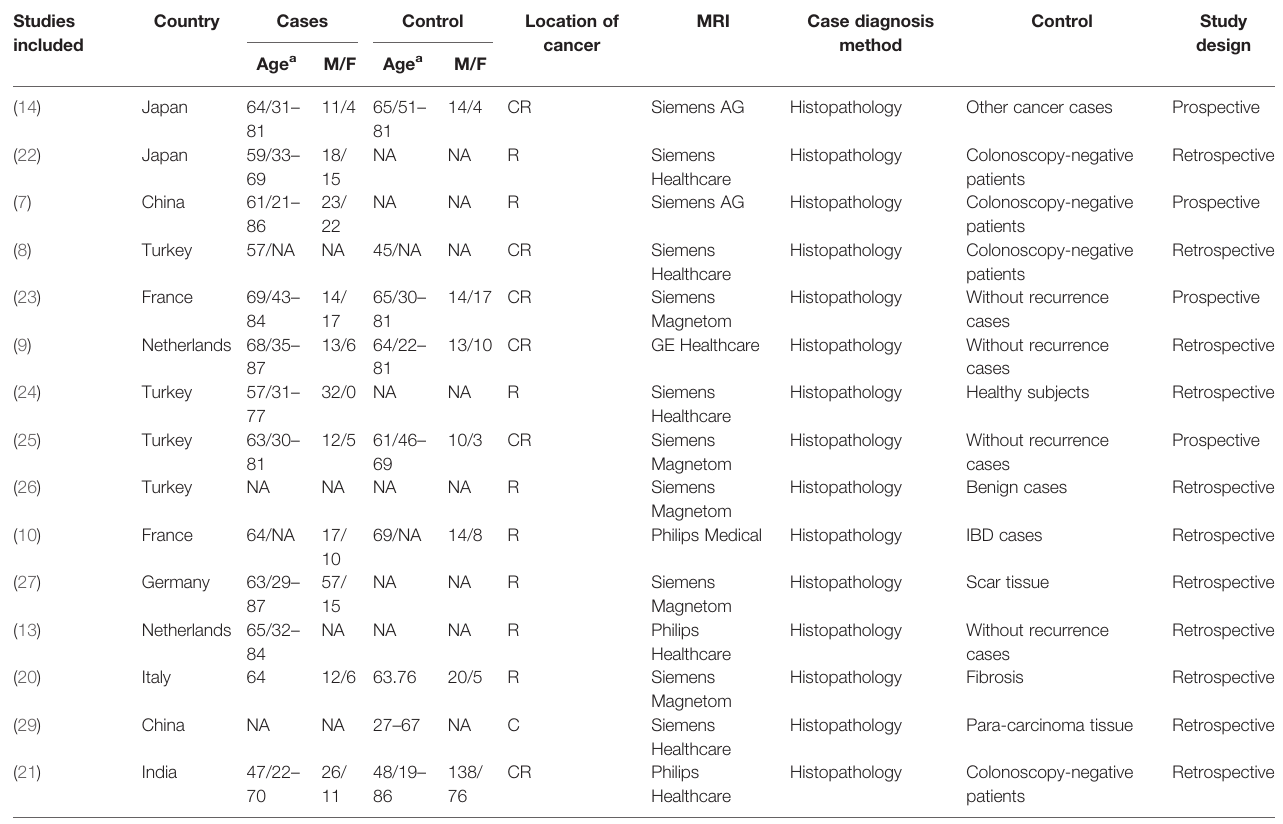
TABLE 1 | Characteristics of the